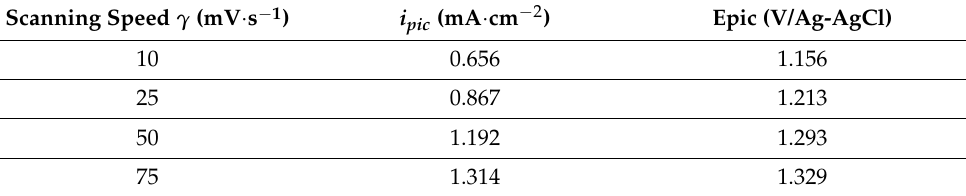
Figure 7. Oxidation-related voltammograms of ATT at different scan rates on 60Cu-Zn40 brass.